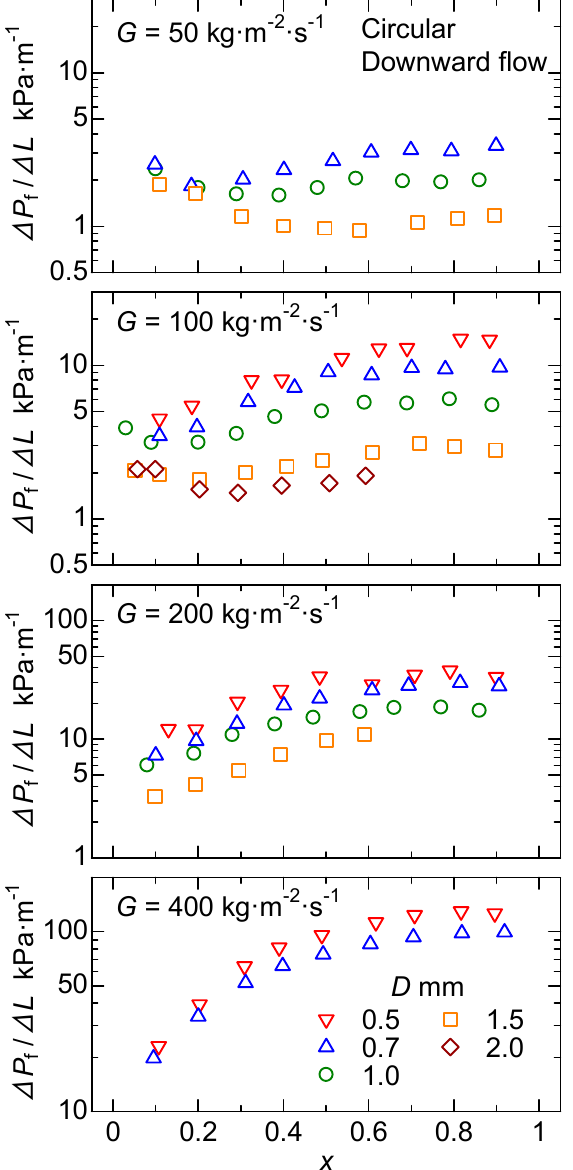
Figure 7. Frictional pressure drop vs. quality in downward flow. (Inner diameter is parameter).